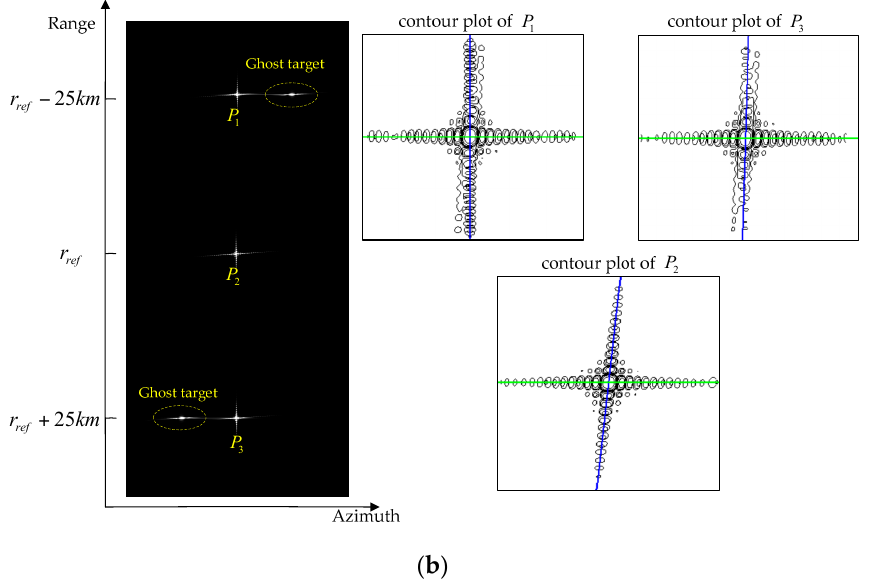
Figure 7. The time aliasing effects: ( a ) aliasing in the time domain after range-independent deramp; ( b ) focusing results and contour plot of the targets.